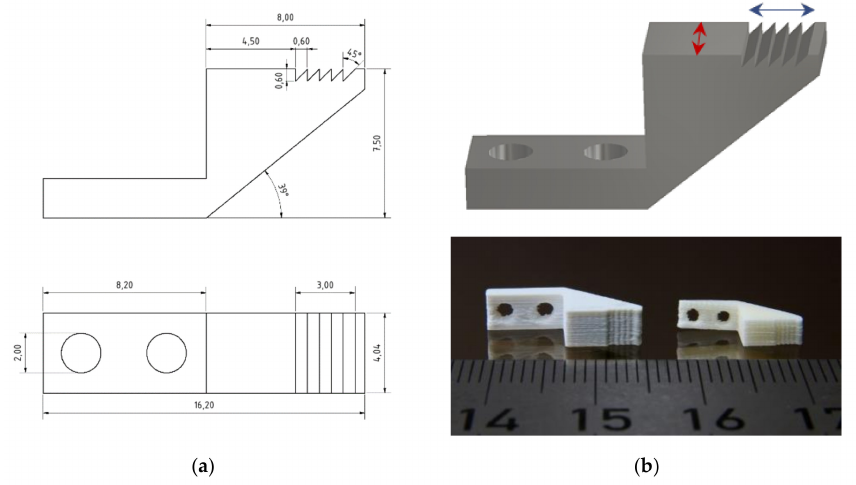
Figure 5. Clamping test structure: ( a ) 2D CAD-drawing and ( b ) Upper image: 3D CAD-drawing indicating scan directions, lower image: printed greenbody and sintered part.